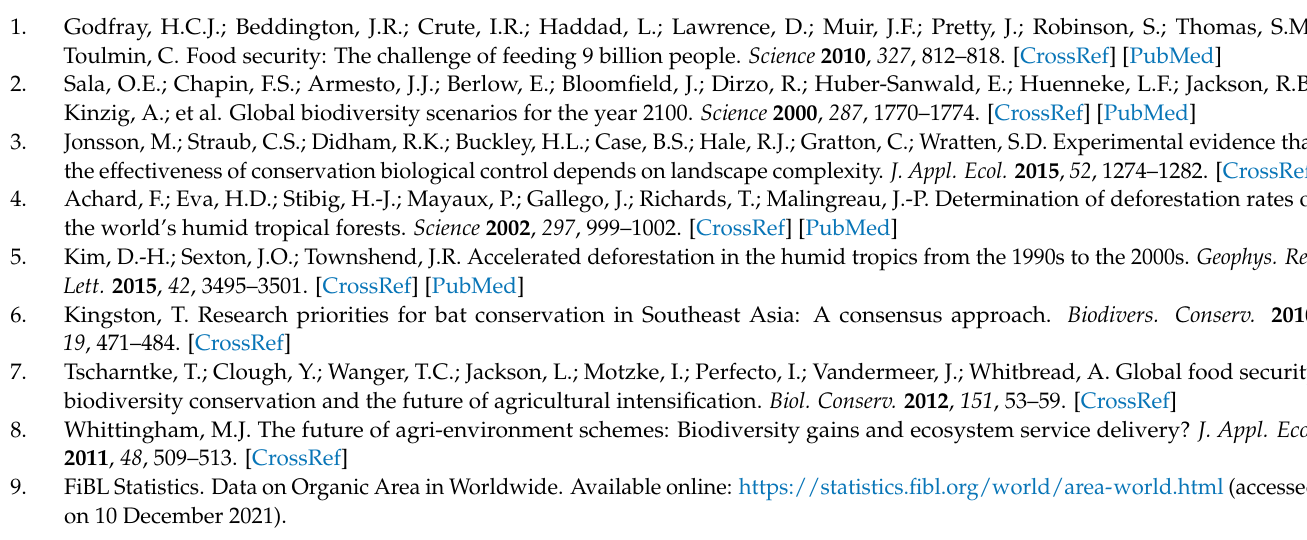
Table S2: Description of the reclassified land cover data, Table S3: Summary of generalized linear mixed model